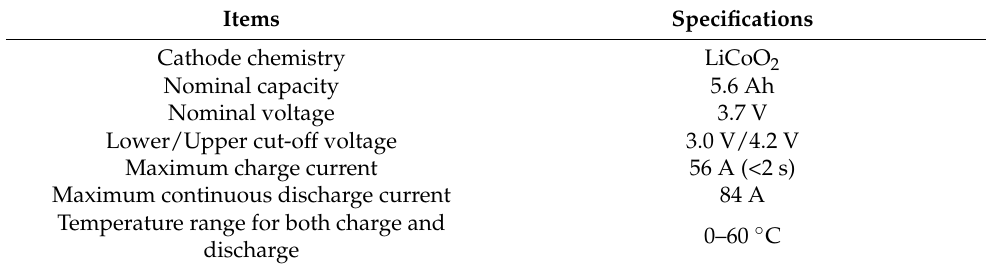
Table 1. Specification of the battery